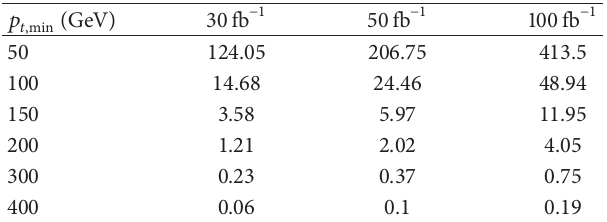
Table3:TheSMeventnumbersof 𝑝𝑝 → 𝑝𝑞𝑞𝑝 processfordifferent values of 𝑝 𝑡 transverse momentum cuts (𝑝 𝑡, min ) and luminosities. Here, acceptance region is taken to be 0.1 < 𝜉 < 0.5